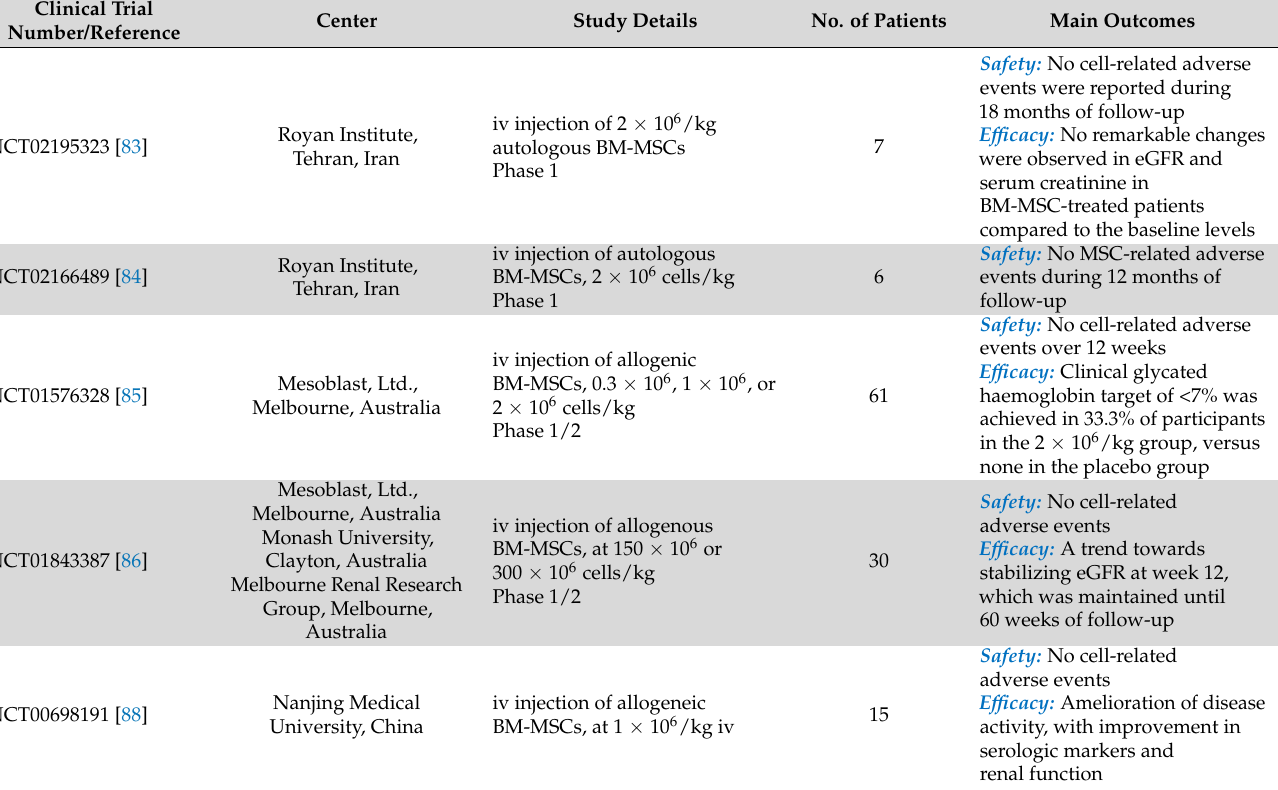
Table 3. Examples of clinical studies investigating BM-MSCs as a treatment for